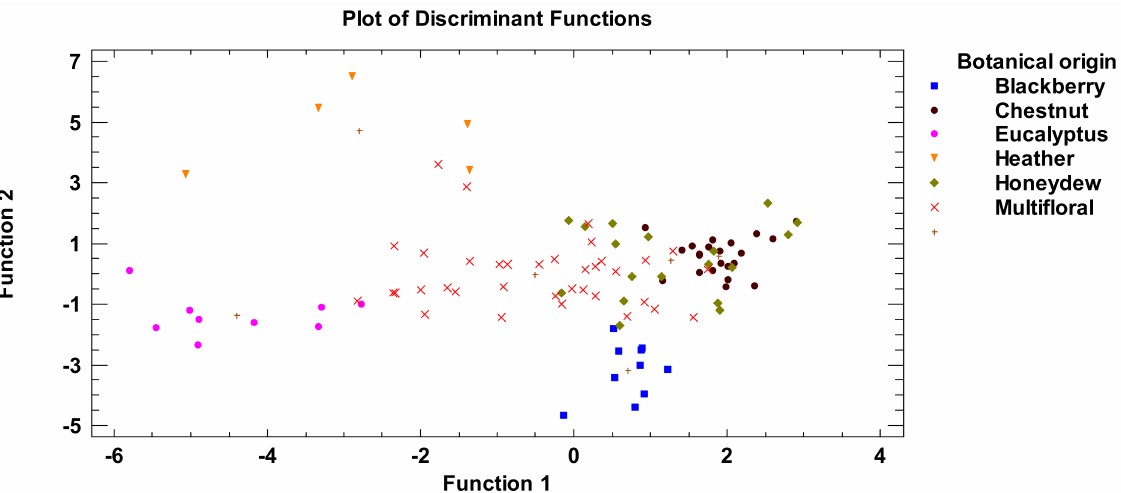
Figure 3. Plot of the first two functions of linear discriminant analysis based on main pollen types and physicochemical characteristics of